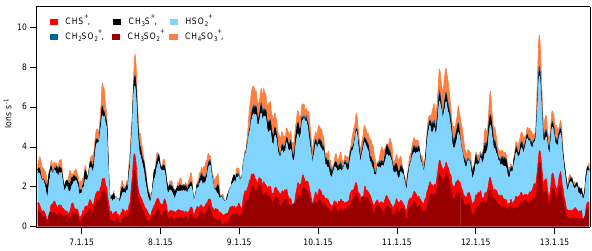
Figure 12. Time series of MSA fragments CHS + (44.98Th), CH 3 S + (47.00Th), HSO + (64.97Th), CH 2 SO + (77.98Th), 2 2 CH 3 SO + (78.99Th) and CH 4 SO + (95.99Th) during episode 2. 2 3 Table 2. Observed MSA ions, their principal isobaric ions and peak separation